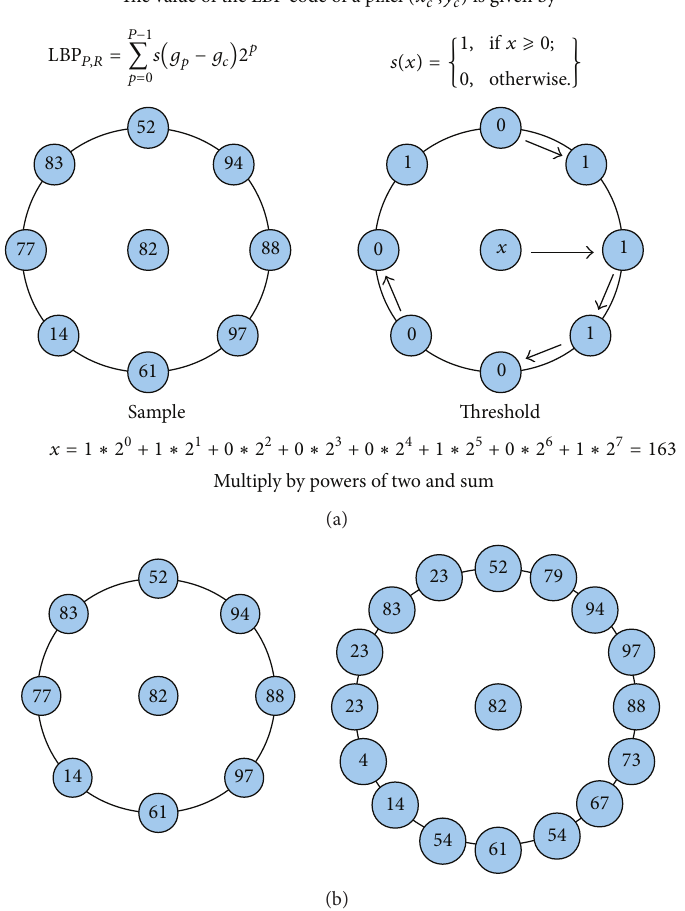
Figure 1: (a) Demonstrates LBP thresholding. A neighbour to a center pixel is set to one if it has equal or higher pixel value and zero if it has lower pixel value. In an anticlockwise manner, every neighbour is multiplied by powers of two and summed as demonstrated in (9). (b) demonstrates how the radius and number of samples can be varied in the choice of neighbourhood. (b) Left figure with small radius and 8 samples. Right figure with large radius and 16